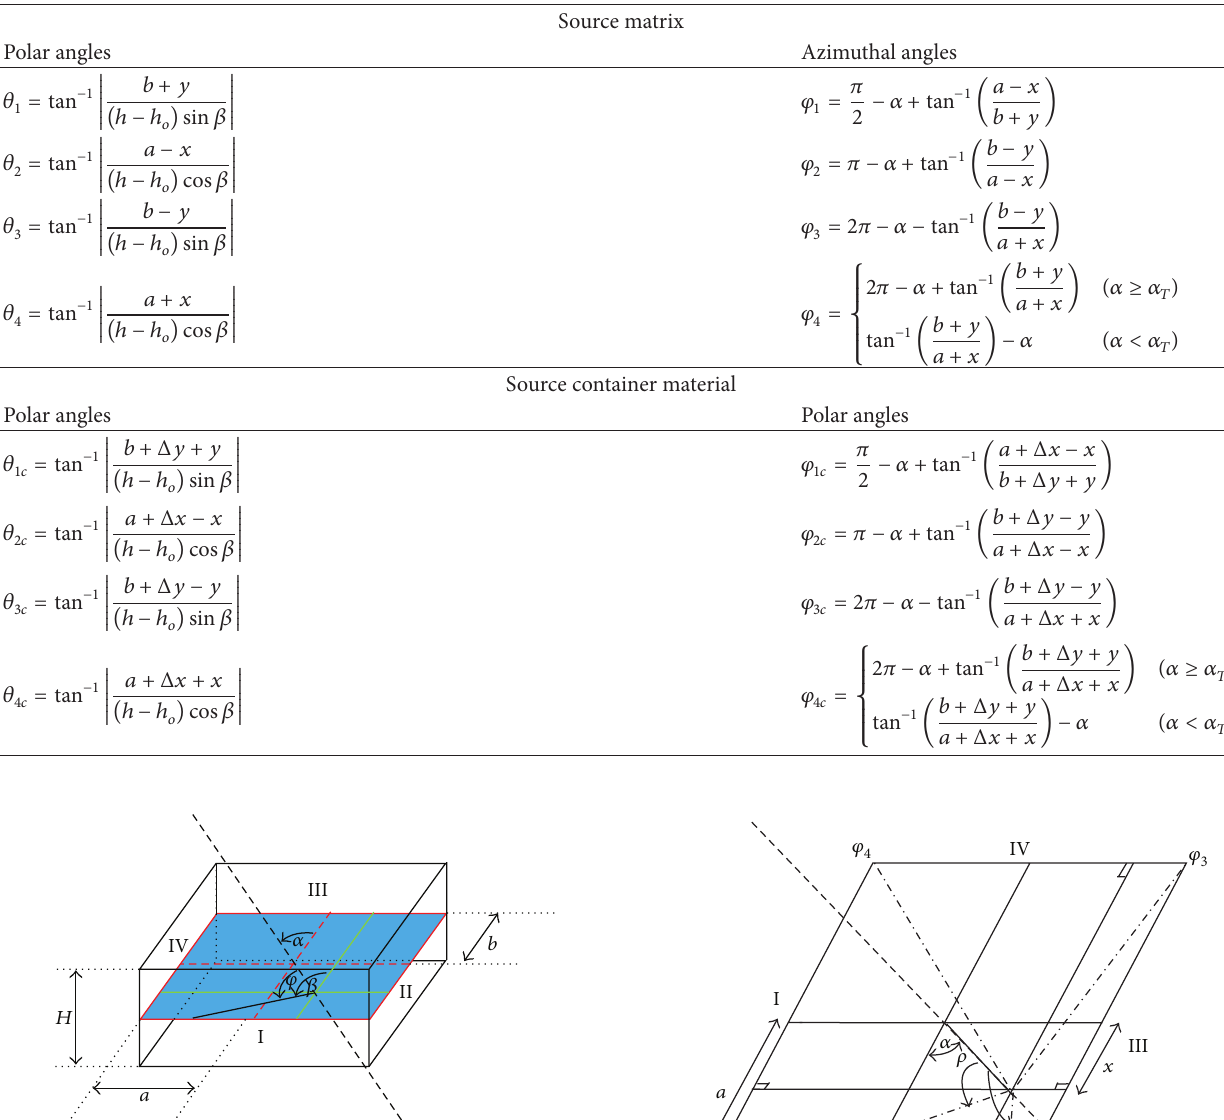
Table 1: The possible path lengths traveled by the photon within the source matrix and the source container material.